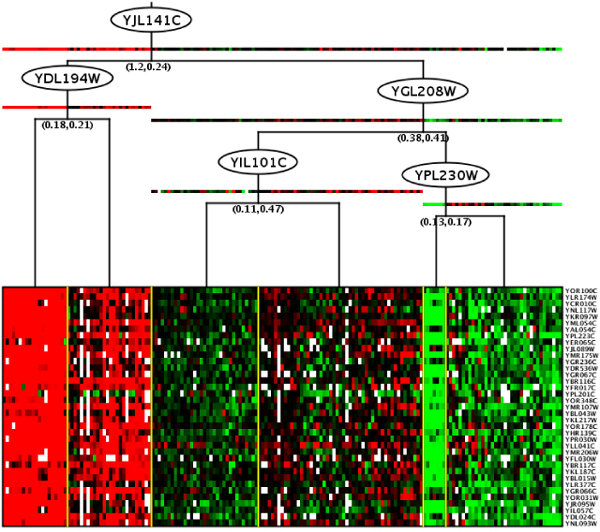
Sample module learned from the Gasch data set [21]. Red and green hues indicate upregulation resp. downregulation. The pairs (x, y) under each split in the regulation tree represent the Bayesian score gain over the split, normalized on the number of genes in the complete network (x), and the regulator assignment entropy (y).